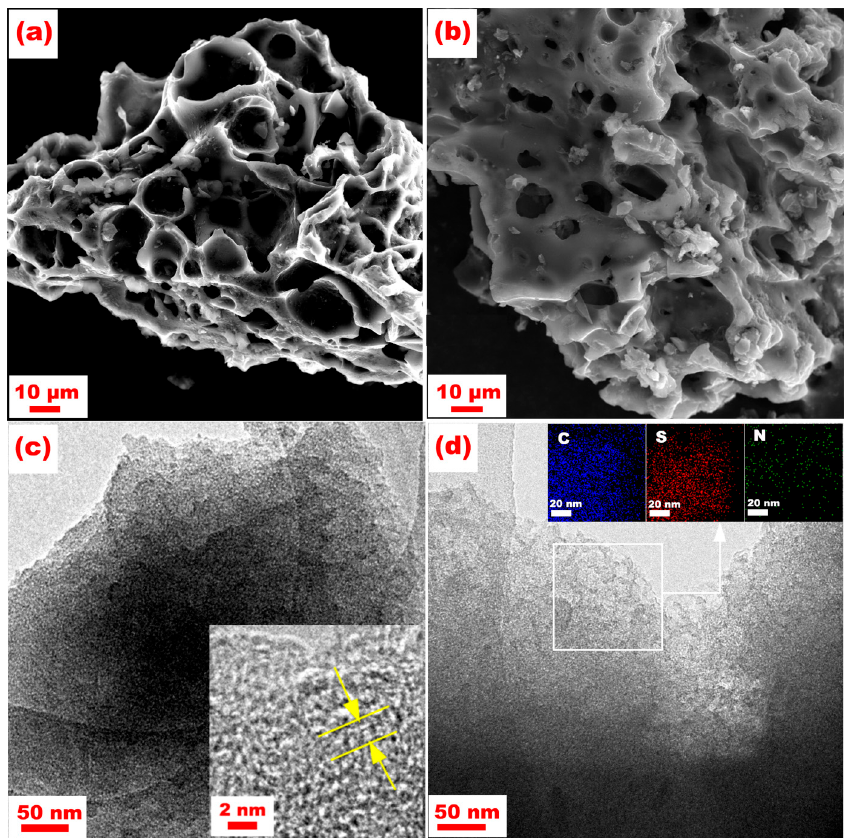
Figure 4. SEM images of ONPC ( a ) and S/ONPC ( b ), and TEM images of ONPC ( c ) and S/ONPC ( d ) including their high magnified views.